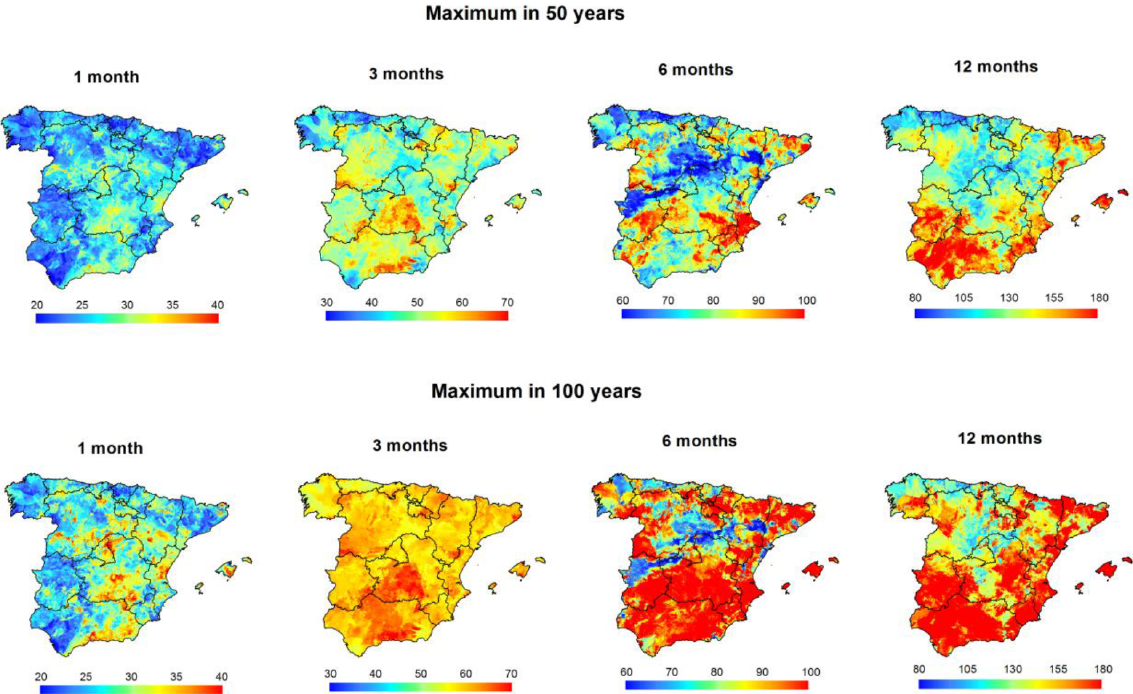
Figure 10. Spatial distribution of the maximum drought duration (in weeks) from the 1-, 3-, 6-, and 12-month SPI series in a period of 50 and 100 years.